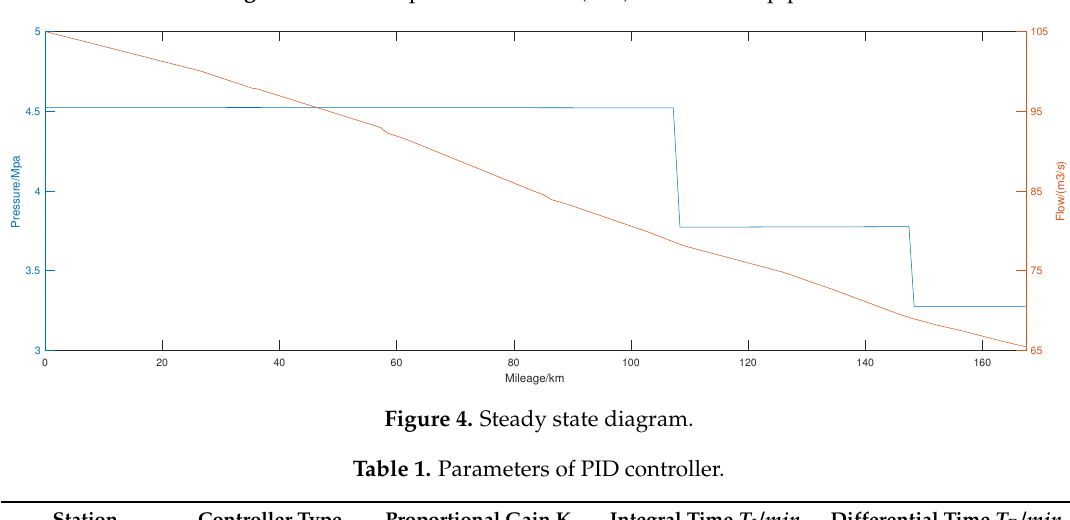
Figure 3. Stoner Pipeline Simulator (SPS) model of the pipeline.